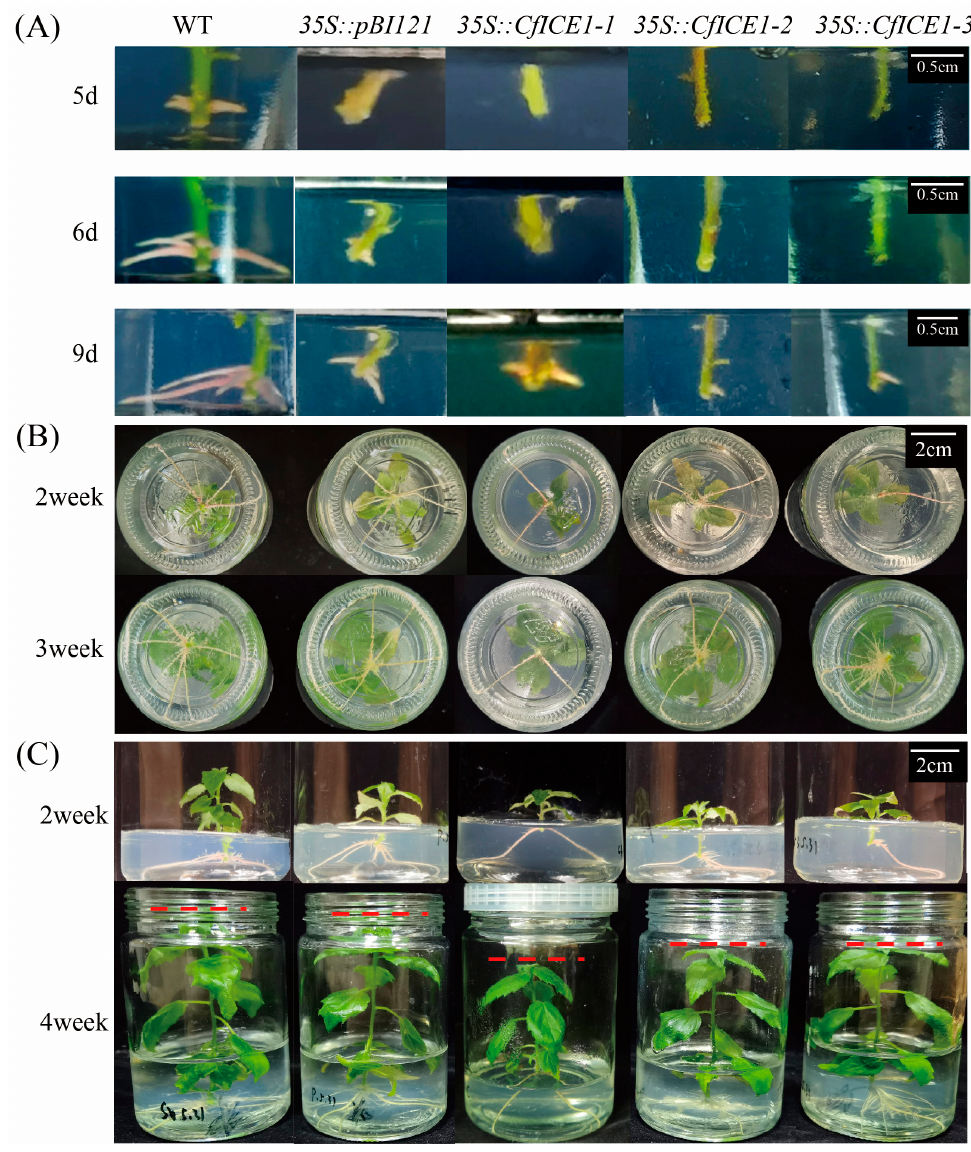
Figure 1. Rooting process of transgenic, empty vector and wild ‐ type poplar lines. ( A ) The formation process of poplar adventitious roots. ( B ) Top view of poplar adventitious roots. ( C ) Comparison of plant height among transgenic, empty vector and wild ‐ type poplar lines. Table 1. Statistics of the plant height, leaf length, width and length/width in wild ‐ type and transgenic poplars. Values shown are mean ± SD (n = 9); p values of Student’s test for transgenic lines and controls poplars are denoted with asterisks.